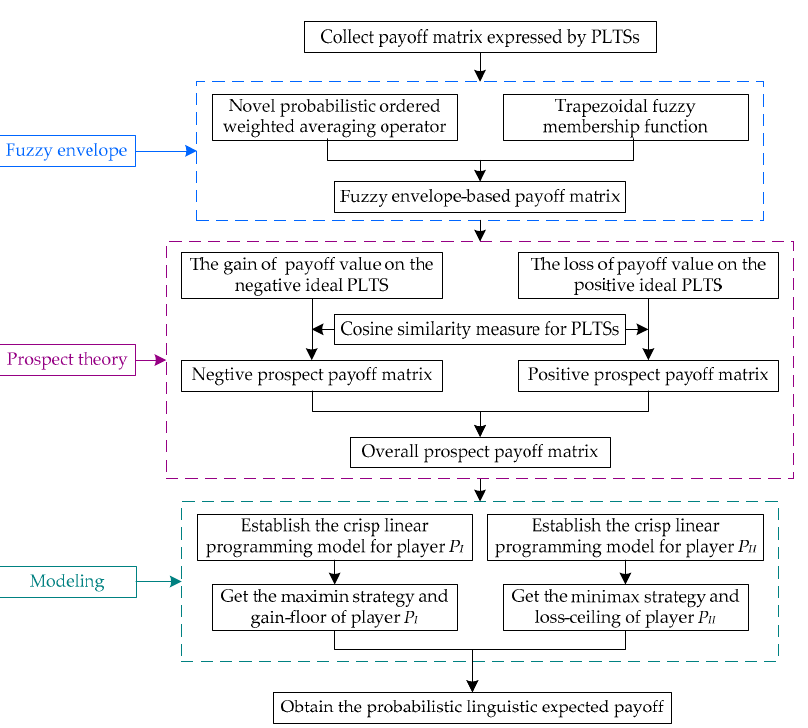
Figure 4. Framework of the proposed method.